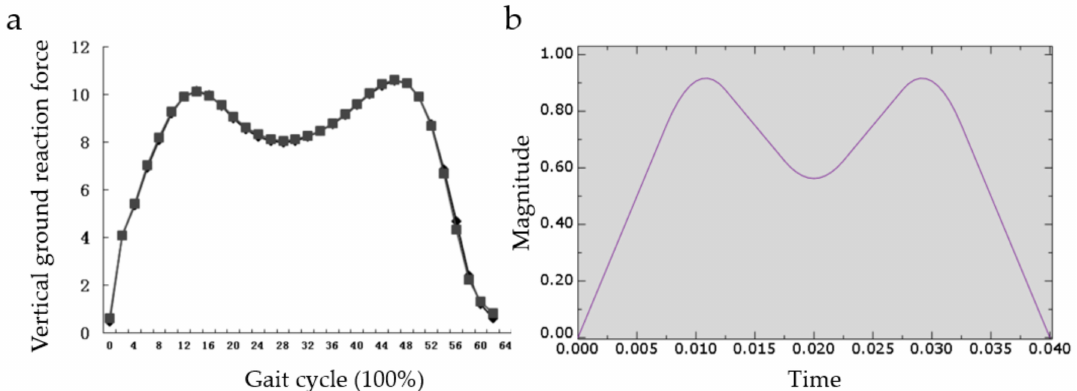
Figure 13. ( a ) Curve of vertical ground reaction force during natural walking; ( b ) Impact force used in FEA.